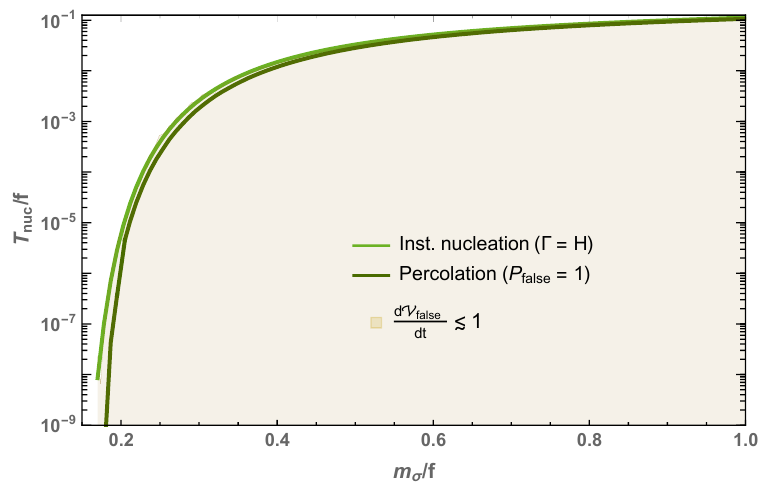
Figure 12 . We compare the nucleation temperature computed from the analytical O (4) action in the thick-wall limit, using either the instantaneous approximation in eq. (2.21), or the refined percolation conditions in eq. (B.39) and eq.